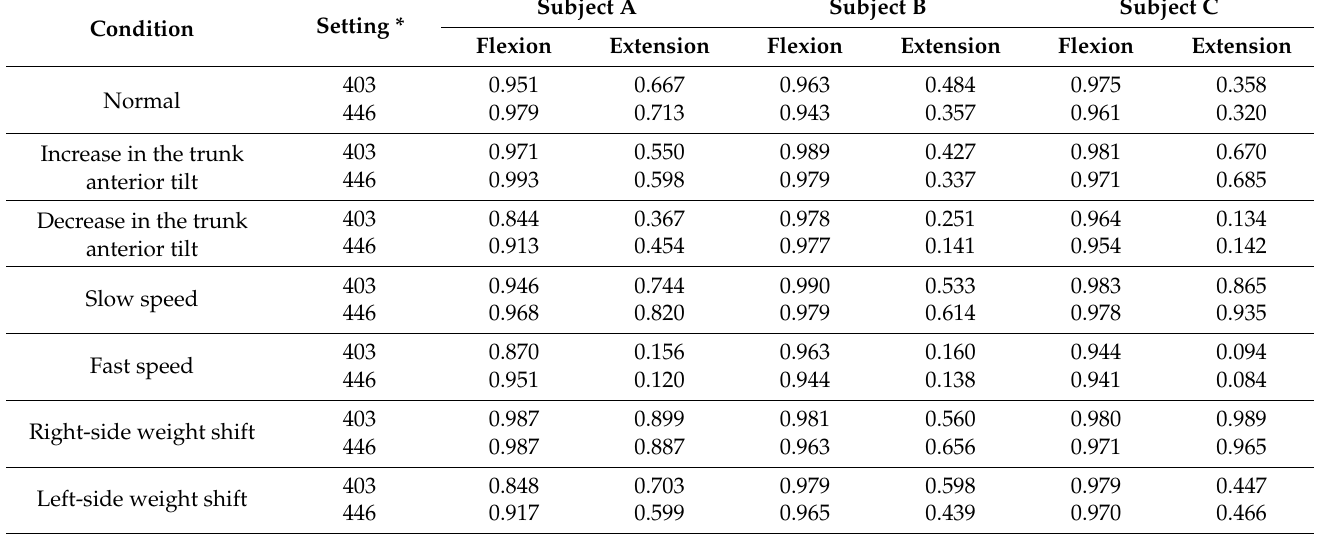
Table 2. Cross-correlation coefficients of trunk angle separated by flexion and extension phase calculated using the chair with embedded laser range finders and the optical motion capture